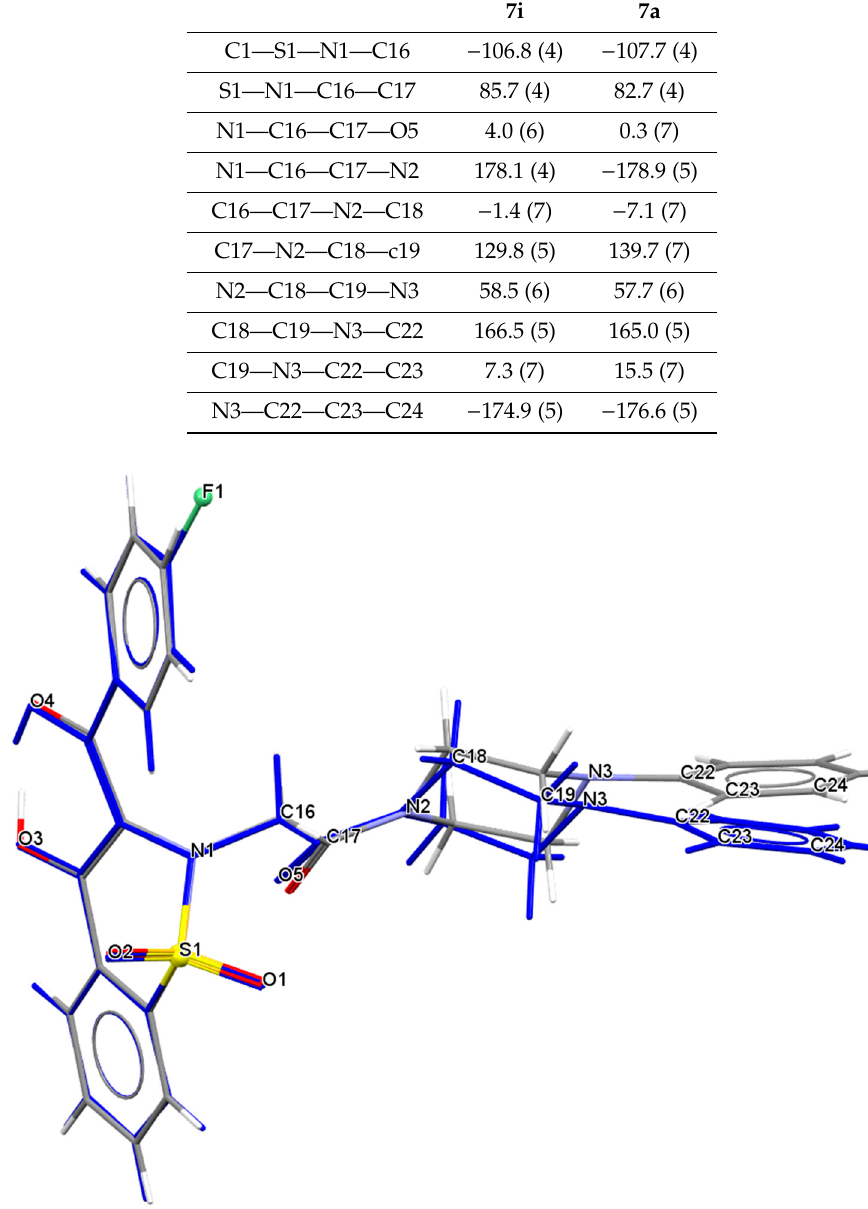
Figure 2. Comparison of conformation of whole molecule 7i (marked in blue) with molecule 7a.